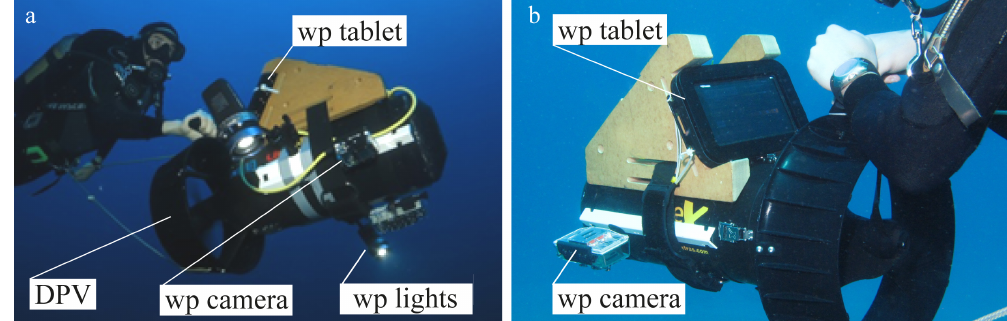
Figure 2. ( a ) A general photograph of the Diver Propulsion Vehicle (DPV) equipped with the Hero3 Silver camera, the waterproof tablet and the lights; ( b ) detailed image of the waterproof camera and tablet. “wp” stands for